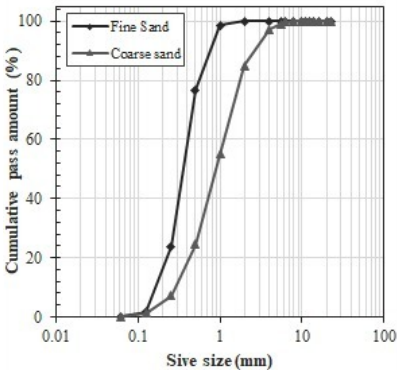
Figure 4. Particle size distribution of aggregates.